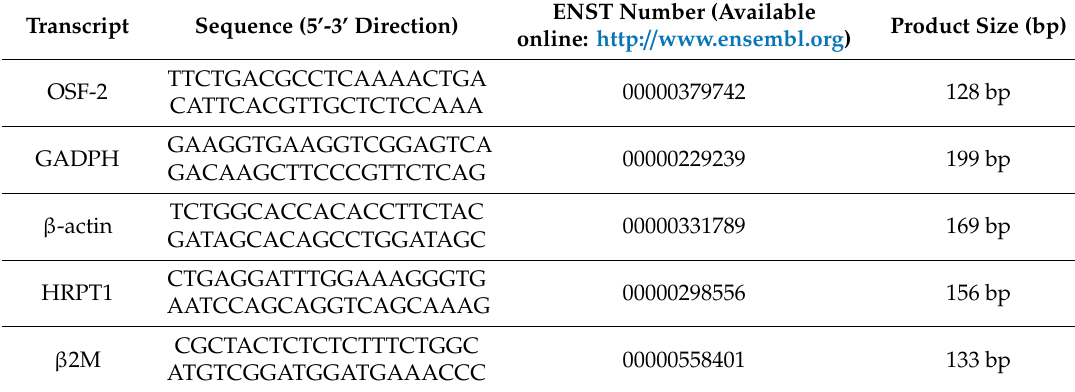
Table 1. Oligonucleotide sequences used for RQ-PCR